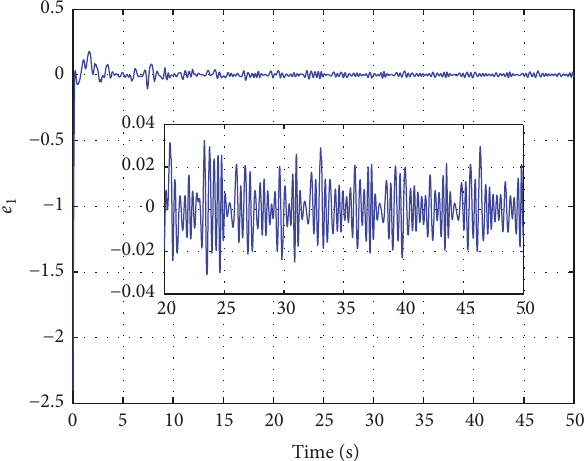
Figure 4: Trajectory of switching signal 𝜎(𝑡) .